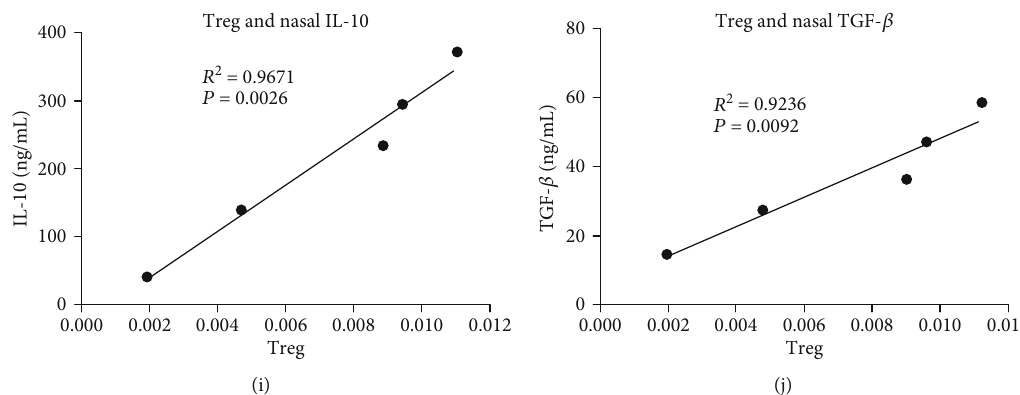
Figure 5: The correlation analyses of cytokine levels and the Treg cell number were analyzed in allogenic o ff spring after transferring CD4 + CD25 + FoxP3 + Tregs from o ff spring in VD3 groups. (a) Treg and IFN- γ , (b) Treg and IL-4, (c) Treg and IL-17, (d) Treg and IL-10, and (e) Treg and TGF- β from peripheral blood of o ff spring mice with VD3 administration were analyzed for their correlation. (f) Treg and IFN- γ , (g) Treg and IL-4, (h) Treg and IL-17, (i) Treg and IL-10, and (j) Treg and TGF- β from NLF of o ff spring mice with VD3 administration were analyzed for their